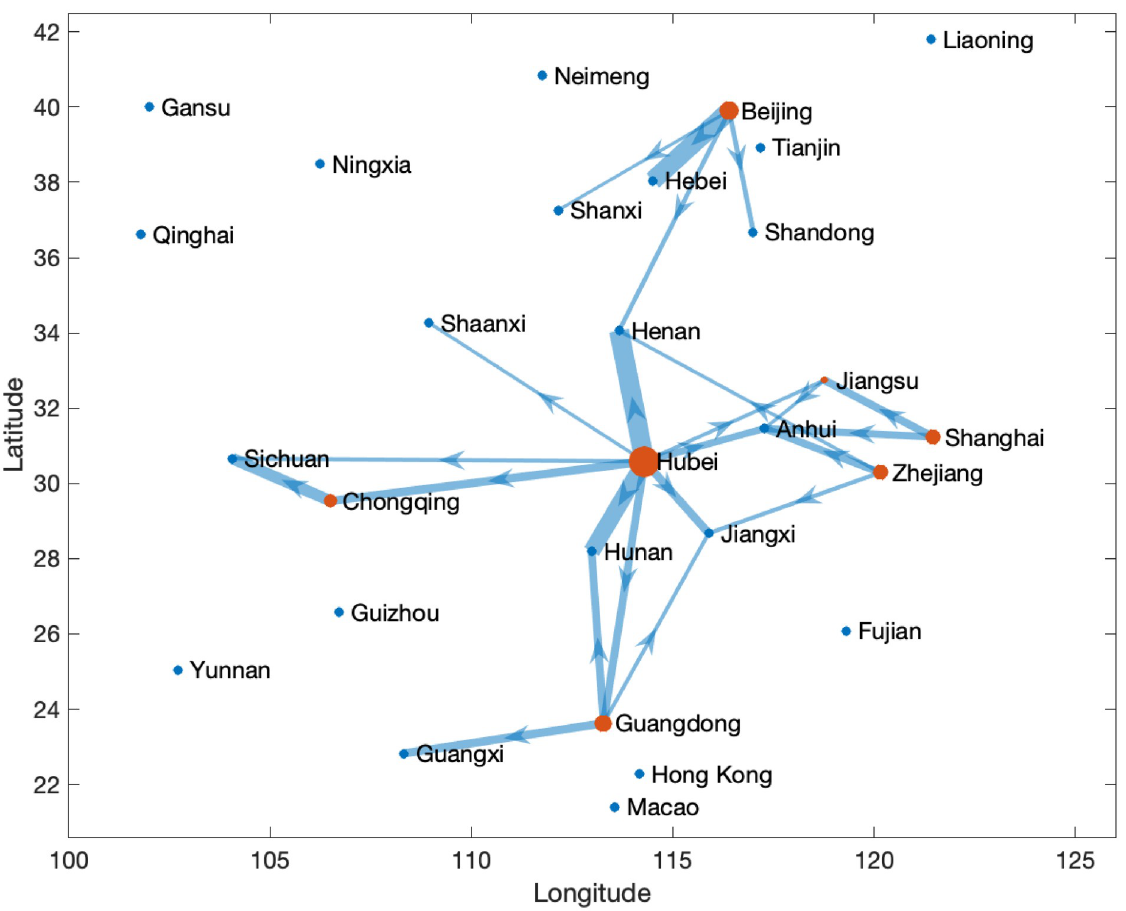
Fig 5. Transmission network on January 27, 2020. Notes : Regions are located geographically. The arrow indicates the direction of transmission; the lines display external transmissions that are greater than two. The line widths are proportional to the external transmission in the indicated direction, and the size of the nodes is proportional to the total export from a